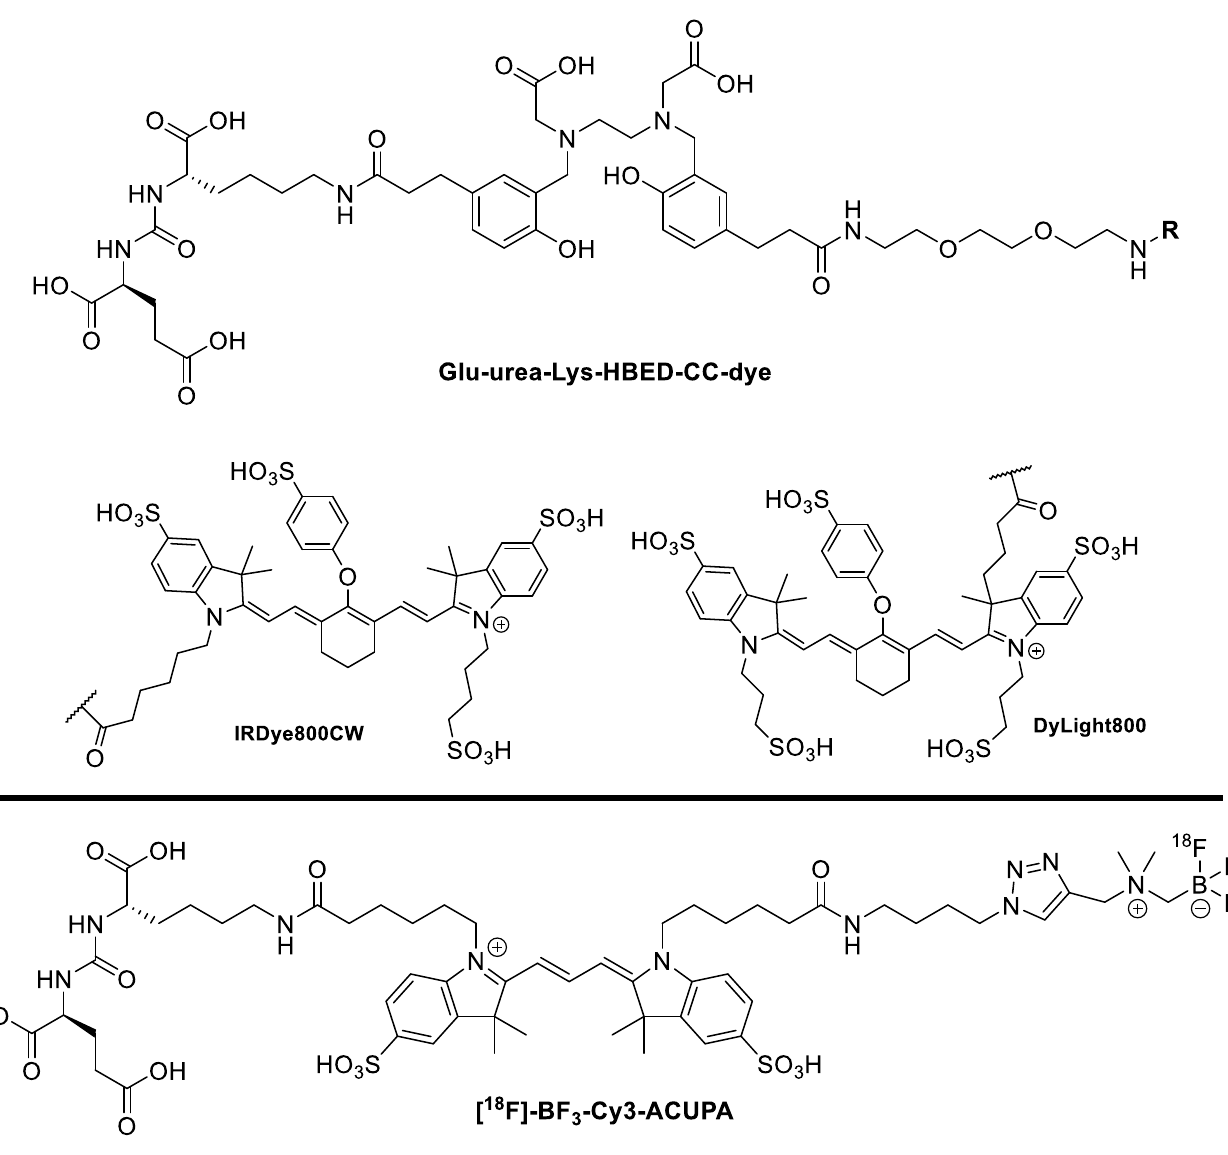
Figure 10. PSMA inhibitor compounds. ( Top ) Glu-urea-Lys-HBED-CC-IRDye800CW: R = IRDye800CW. Glu-urea-Lys-HBED-CC-DyLight800 : R = DyLight800. ( Bottom ) [ 18 F]-BF 3 -Cy3-ACUPA .